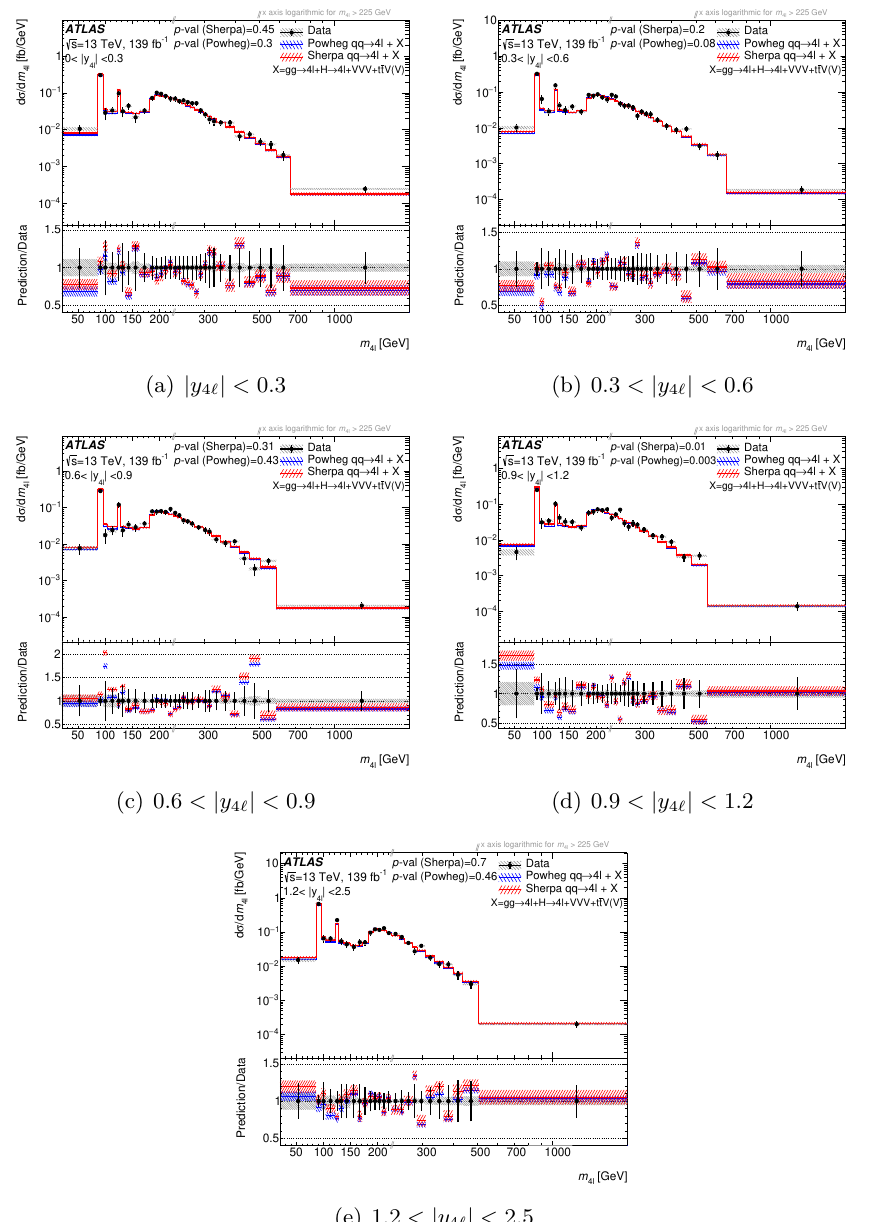
Figure 16 . Differential cross-section as a function of m 4 ‘ in | y 4 ‘ | slices. The measured data (black points) are compared with the SM prediction using either Sherpa (red, with red hashed band for the uncertainty) or Powheg + Pythia8 (blue, with blue hashed band for the uncertainty) to model the q ¯ q → 4 ‘ contribution. The error bars on the data points give the total uncertainty and the grey hashed band gives the systematic uncertainty. The p -value is the probability for the χ 2 , with the number of degrees of freedom equal to the number of bins in the distribution, to have at least the observed value, given the SM prediction. The lower panel shows the ratio of the SM predictions to the data. The x -axis is on a linear scale until m = 225 GeV, where it switches to 4 ‘ a logarithmic